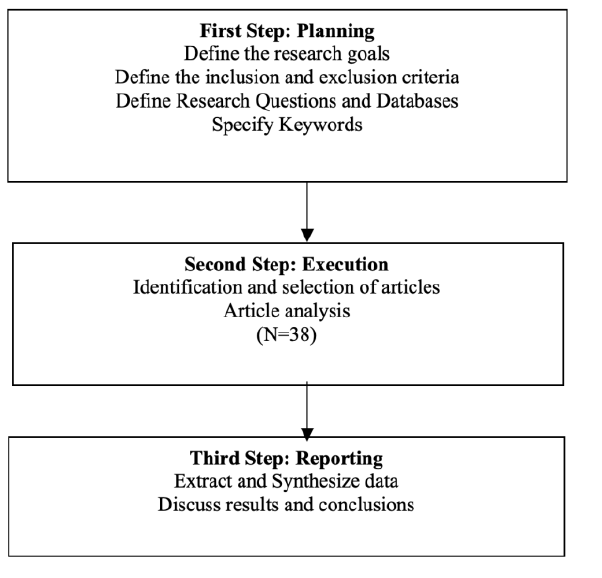
Figure 1: The systematic literature review process; Source: Authors